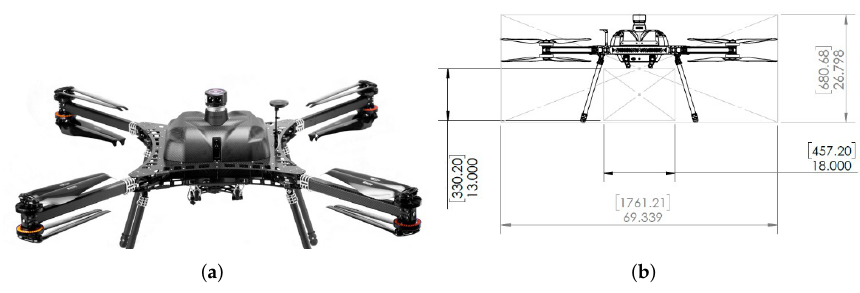
Figure 3. UAS platform. ( a ) Harris Aerial HX8. ( b ) HX8